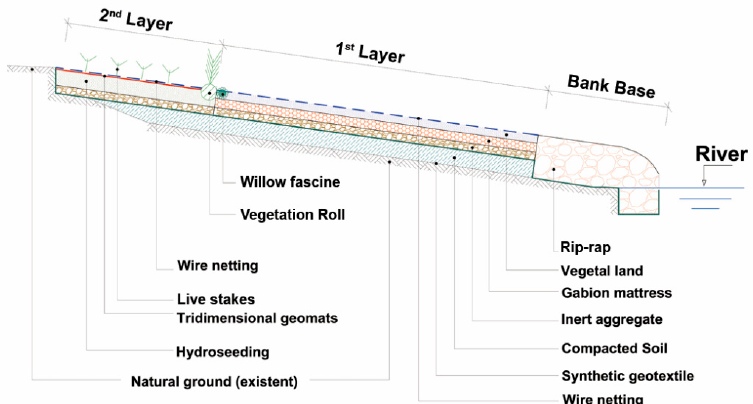
Figure 4. Planned techniques and vegetation species along the bank profile designed for the Cardielos site.